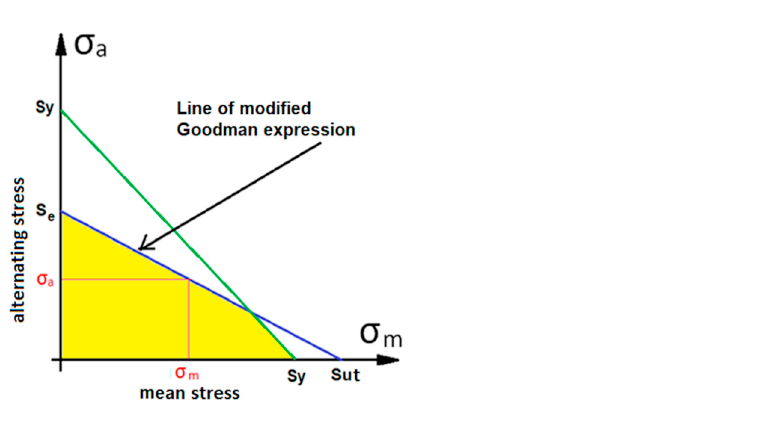
Figure 3. Diagram of the clamp operation (lever effect).